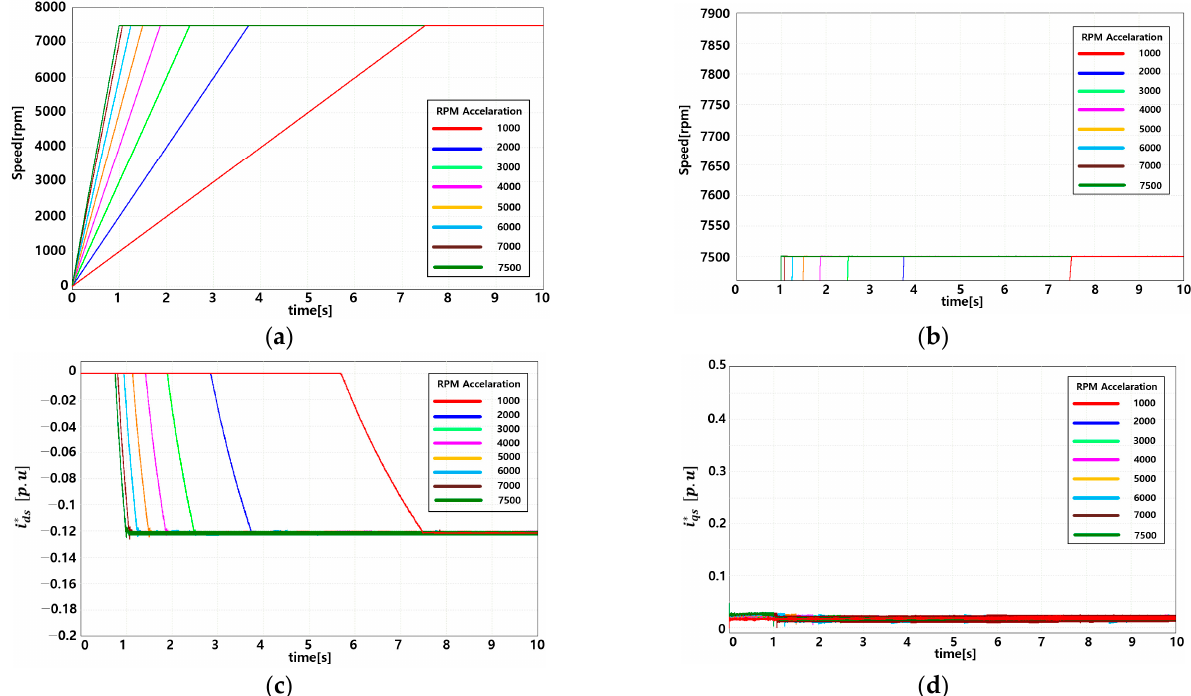
Figure 7. Simulation results when ∆𝑖 (cid:3031)(cid:3046)∗ is optimized: ( a ) motor speed; ( b ) motor speed; ( c ) d-axis current; ( d ) q-axis current.